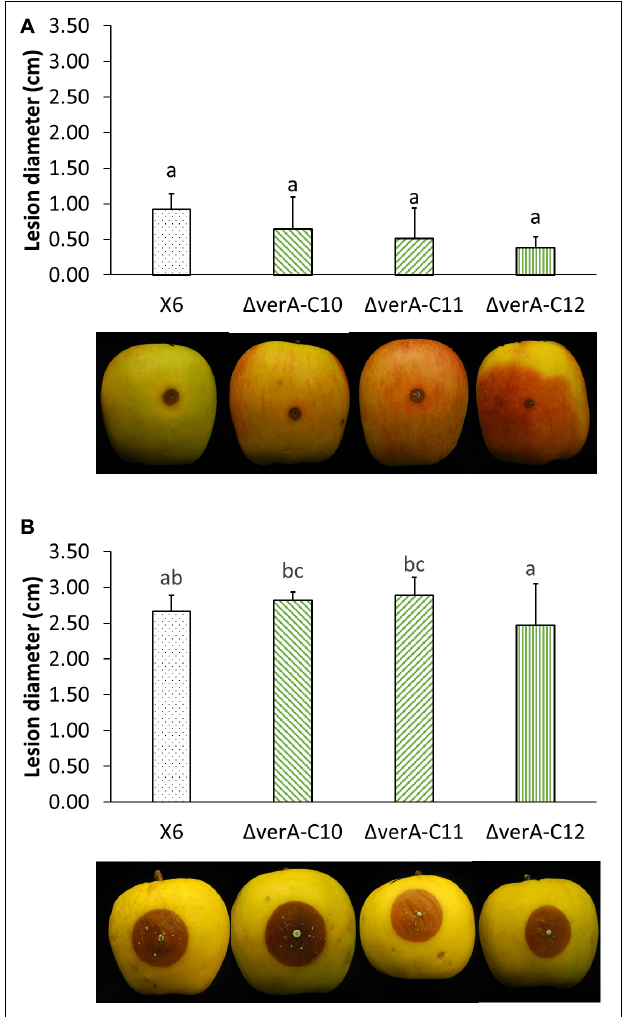
FIGURE 5 | Analysis of verA deletion on the virulence of P. polonicum in vivo. Lesion diameter (cm) and pictures of apples cv. Ambrosia (A) and Opal (B) were recorded 14 days after inoculation. WT, wild-type P. polonicum X6; (cid:49) verA, deletion mutants for verA ( cl4A ). Values followed by the same letter are not statistically different by Tukey’s b multiple comparison test ( p <